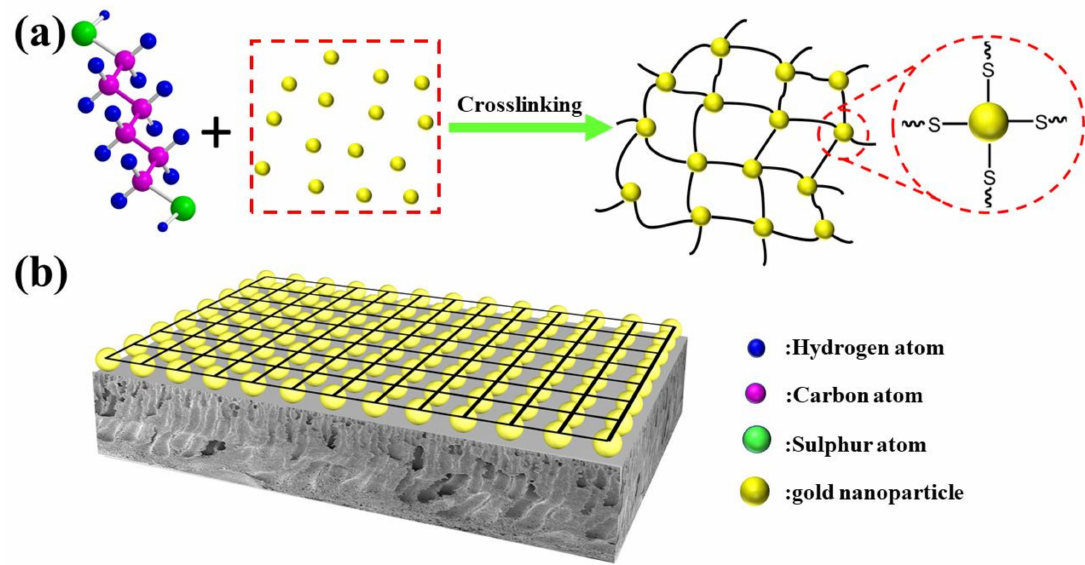
Figure 1. Schematic illustration of fabricating ( a ) the crosslinked gold nanoparticles ( b ) modified